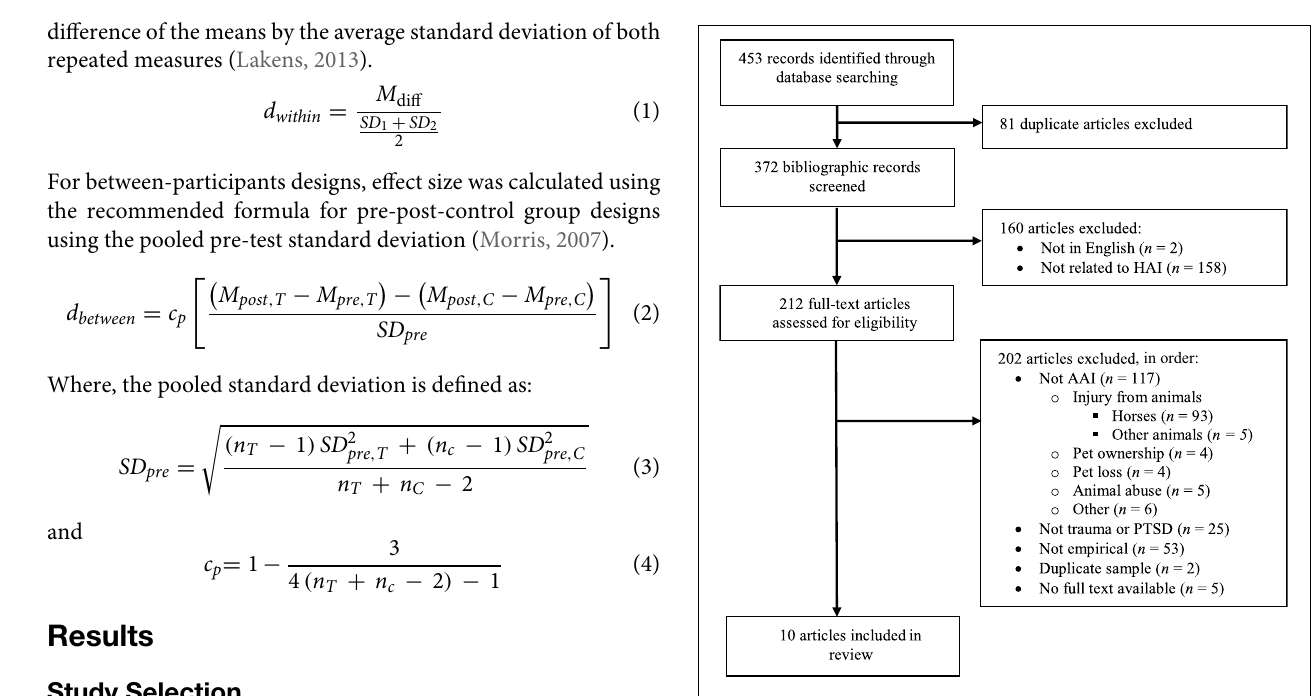
FIGURE 1 | Flow chart of study selection process. HAI, human animal interaction; AAI, animal-assisted intervention; PTSD, posttraumatic stress